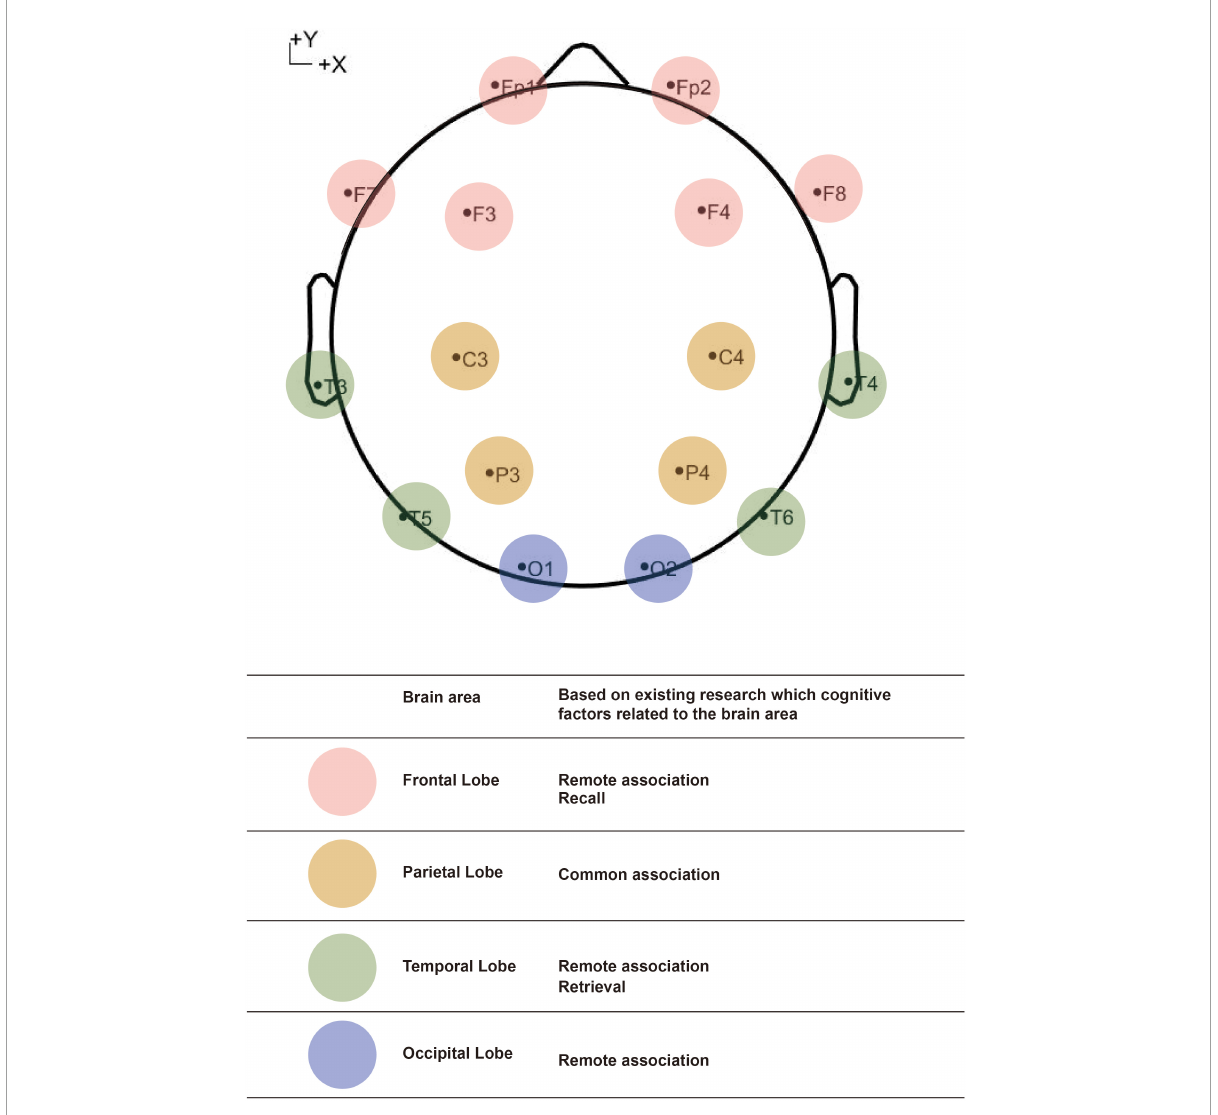
FIGURE2 The position of the 16 scalps and the relations between the 16 channels and brain areas, and which cognitive factors related to the brain areas have been